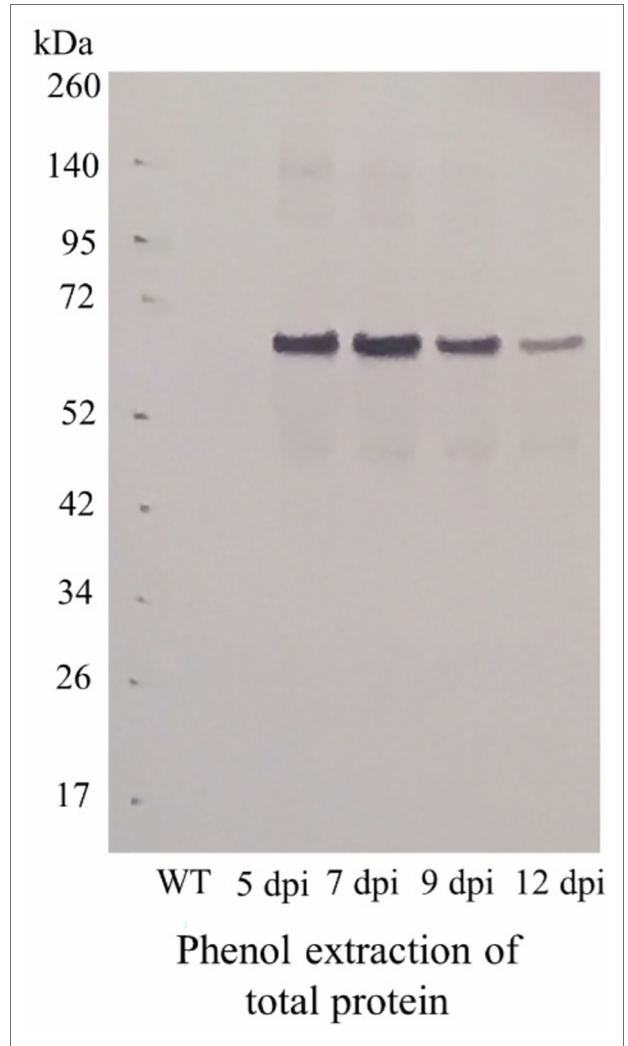
FIGURE 2 | Accumulation of Lac51 protein in Nicotiana benthamiana leaves. Immunoblot analysis of total protein extracts from N. benthamiana leaves infiltrated with the lac51 construct, harvested 5, 7, 9, and 12 days after infiltration (dpi) or non-infiltrated leaves